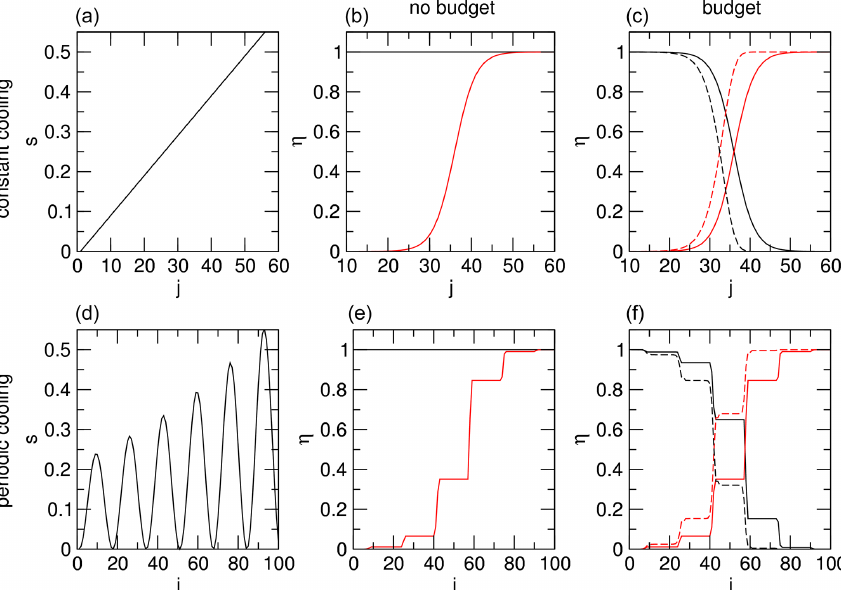
Figure 3. Evolution of deterministic ice formation events driven by (a–c) constant cooling and (d–f) periodically oscillating cooling and heating, as indicated by panels (a) and (d) , which show ice supersaturation versus dimensionless time. Panels (b) , (c) , (e) , and (f) show the resulting evolution of (black) INP and (red) cumulated ice crystal numbers in a model without and with the budgeting of particle numbers based on the cumulative AF from Eq. (7) with s ∗ = 0 . 35 and δs = 0 . 05 and the associated differential AFs, respectively. The dashed curves in the “budget” approach were obtained by wrongly using the cumulative AF so that the difference from the solid curves indicates the error in simulated particle